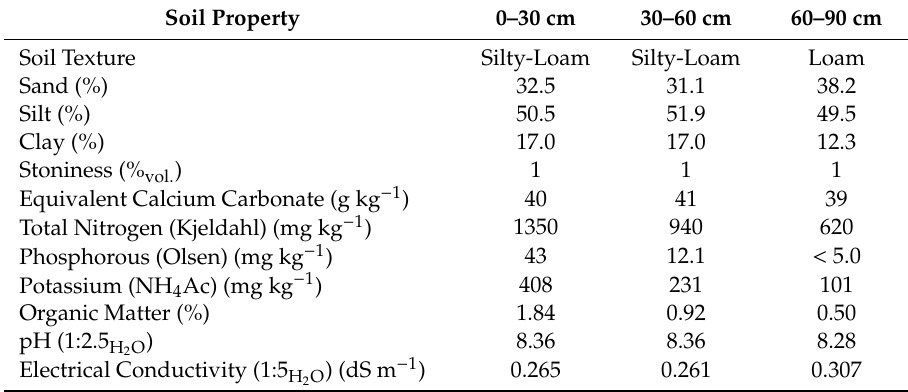
Table 1. Main physicochemical soil characteristics at the beginning of the experiment (2015).